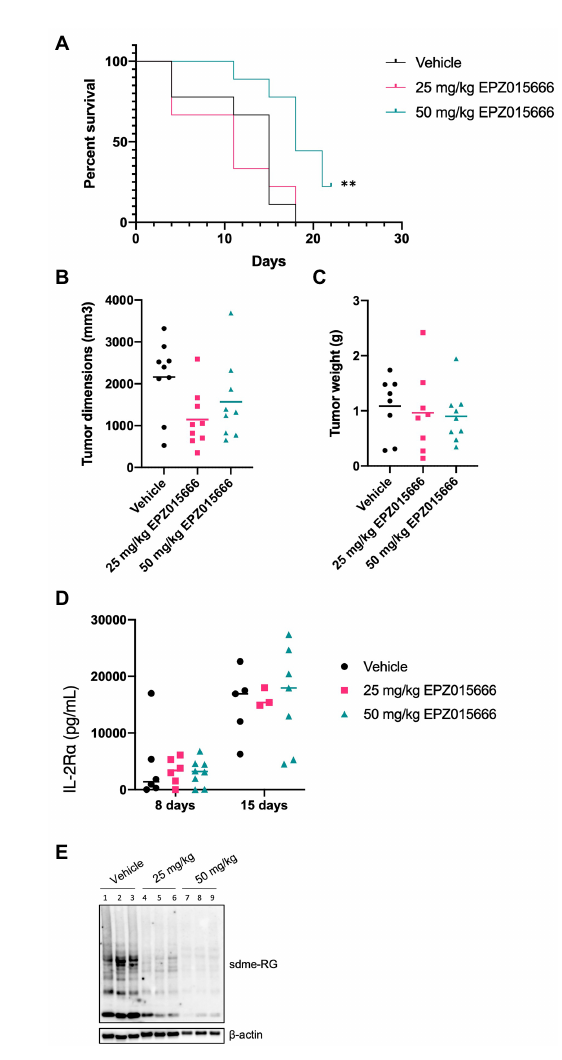
FIGURE 5 EPZ015666 increases survival in SLB-1 xenograft NSG mice. NSG mice were inoculated subcutaneously with 1×10 7 SLB-1 cells. All the mice developed measurable tumors by day 8. Bidaily oral administration of